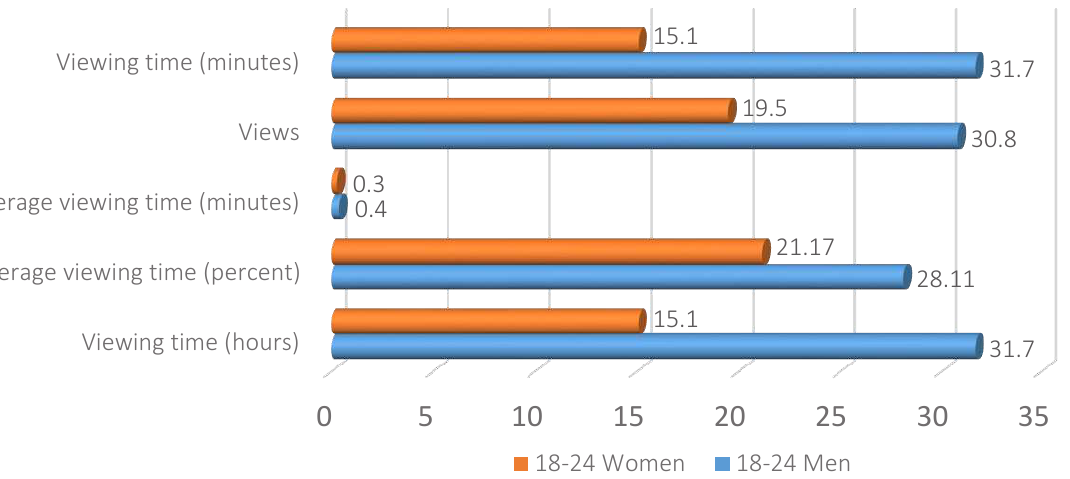
Figure 5. Gender peculiarities of viewing a video clip for 21 days for people aged 18-24 years